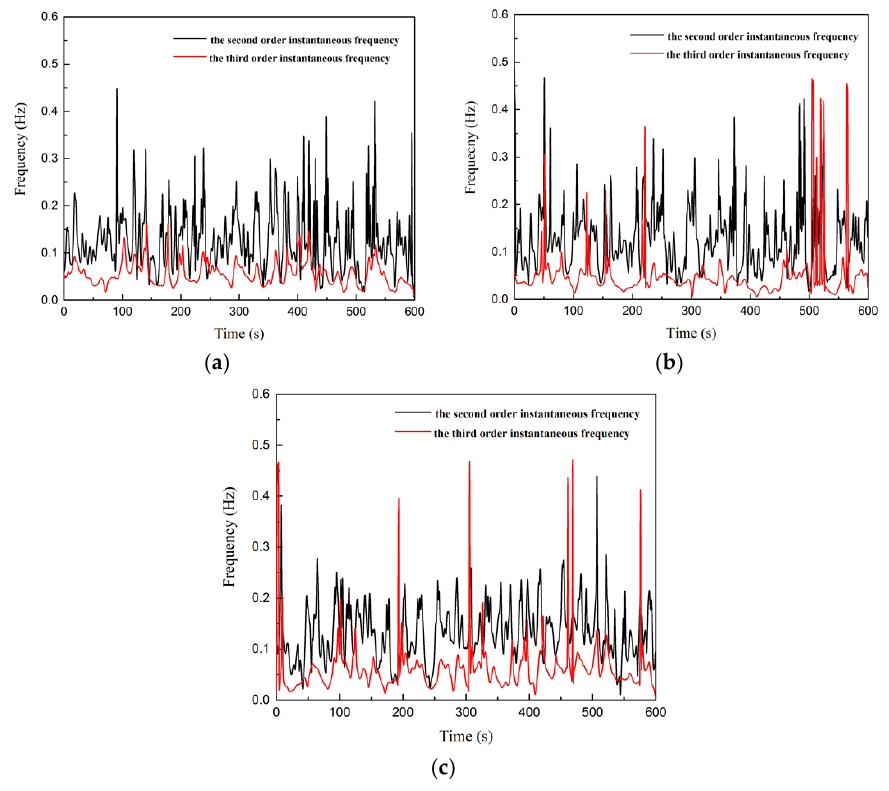
Figure 11. Comparison of the instantaneous frequencies. ( a ) simulation by Kaimal spectrum; ( b ) simulation by Von Karman spectrum; ( c ) simulation by measured spectrum.